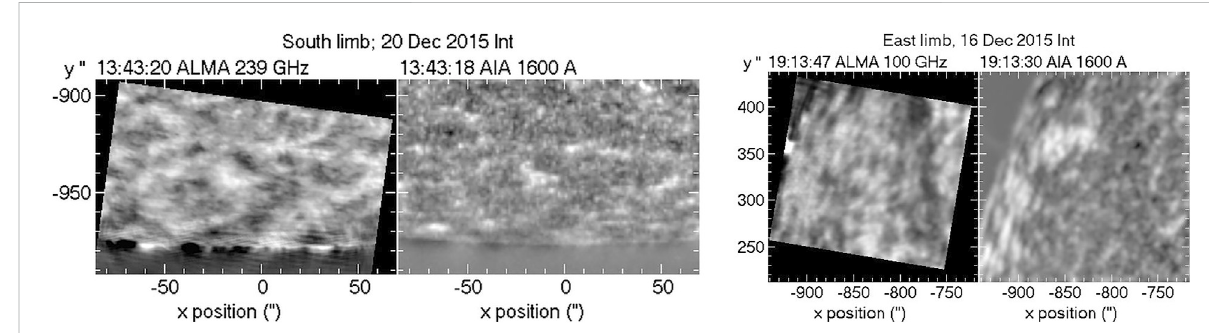
FIGURE 10 ALMA images near the S and E limbs obtained during the commissioning period, together with the corresponding AIA 1600 Å images. A plage region is visible near the E limb. All images have been corrected for CLV, by subtracting 85% of the azimuthally averaged intensity; AIA images were smoothed to the ALMA resolution of 1.76 by 1.01 ″ at 239 GHz and 5.45 by 4.00 ″ at 100 GHz. Solar north is up. Figure made by the authors from data set ADS/JAO. ALMA. 2011.0.00020. SV.